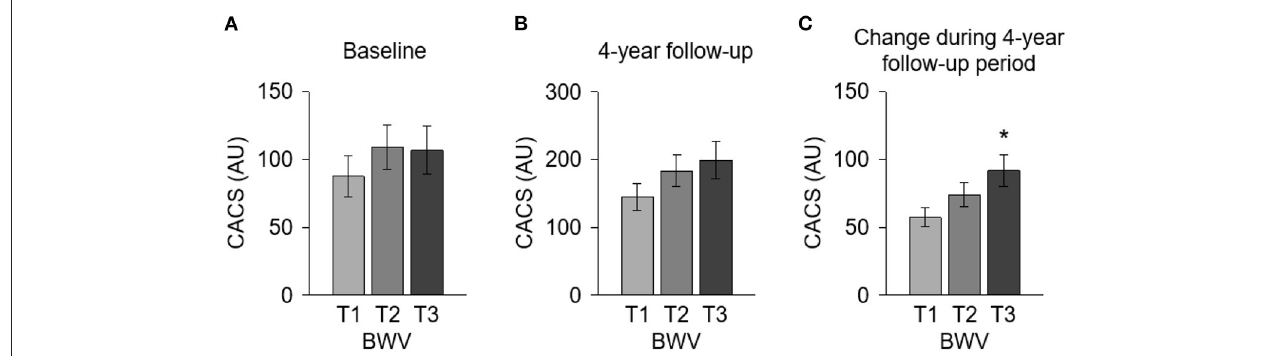
FIGURE 2 | Comparison of the CACS at the baseline and at 4-year follow-up and the CACS change during 4-year follow-up period by BWV. CACS at the baseline (A) and at 4-year follow-up (B) and the CACS change during the 4-year follow-up period (C) were compared by BWV. * P < 0.05 vs. T1 by one-way ANOVA with Scheffe’s post-hoc test. Error bars indicate SE of means. AU, Agatston unit; BWV, body weight variability; CACS, coronary artery calcium score; T1, 1st tertile; T2, 2nd tertile; T3, 3rd tertile.